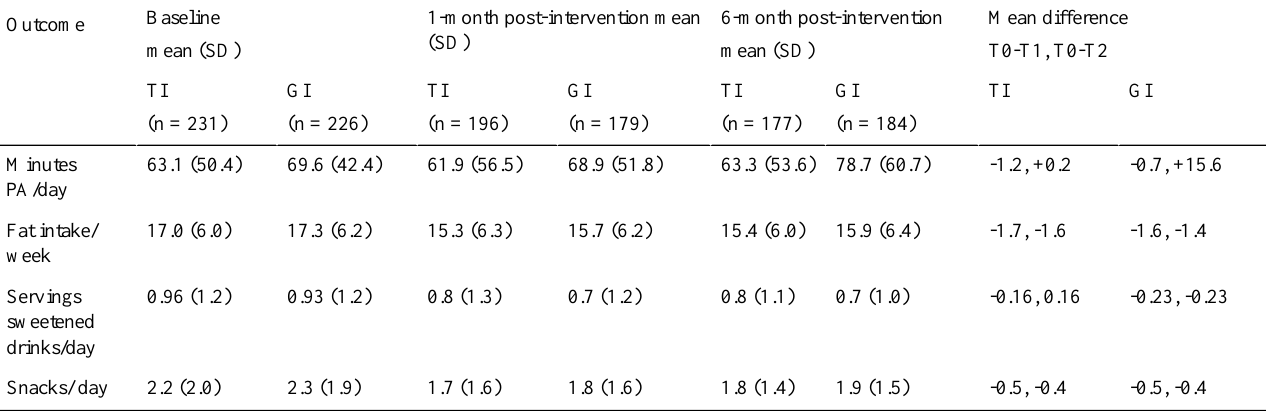
Table 4. Crude means and difference of specific self-reported behavior (DI and PA) at baseline, and 1- and 6-month post-intervention (N=495).